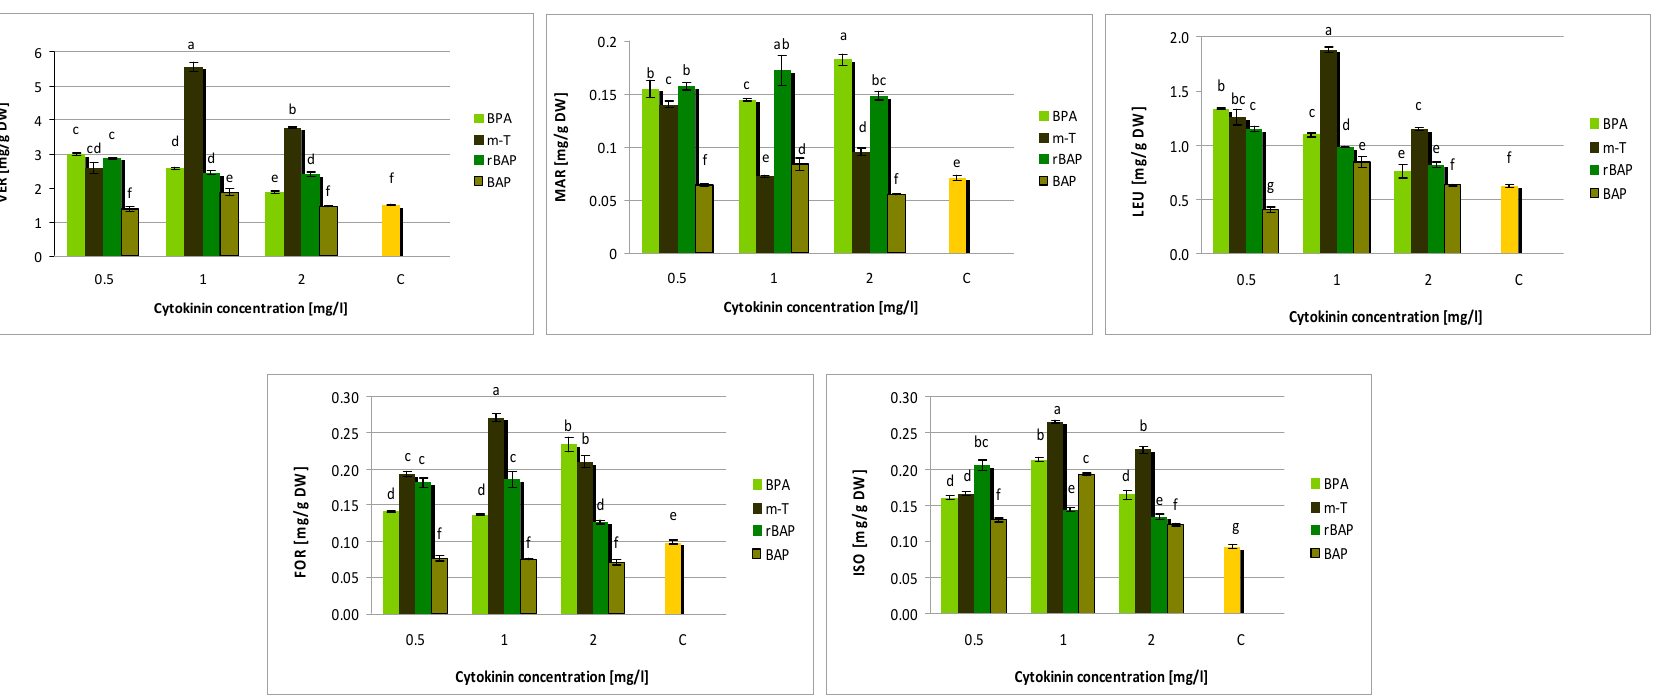
Figure 5. Effect of cytokinin type and concentration on phenylethanoid content (mg/g DW) in shoot culture of S. viridis. VER—verbascoside, MAR—martynoside, LEU—leucosceptoside A, FOR—forsythoside A, ISO—isoverbascoside; C—control, shoots cultivated on MS medium only with auxin (0.1 mg/L IAA). The values represent the mean ± standard error of three independent experiments. Means marked with the same letter were not significantly different according to the one-way ANOVA test, followed by the post hoc Tukey’s test for multiple comparison ( p ≤ 0.05).